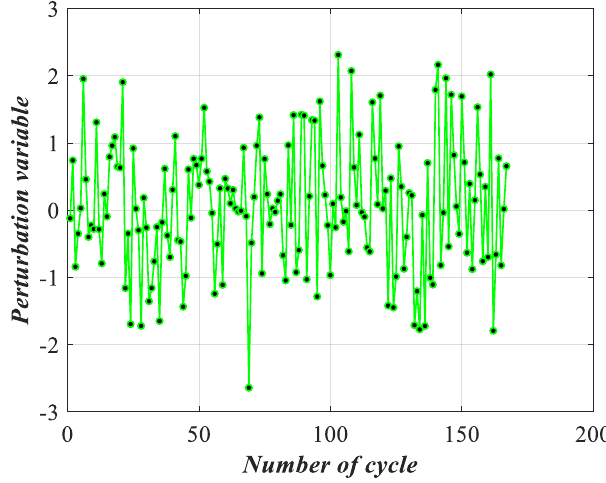
Figure 10. Perturbation variable distribution.